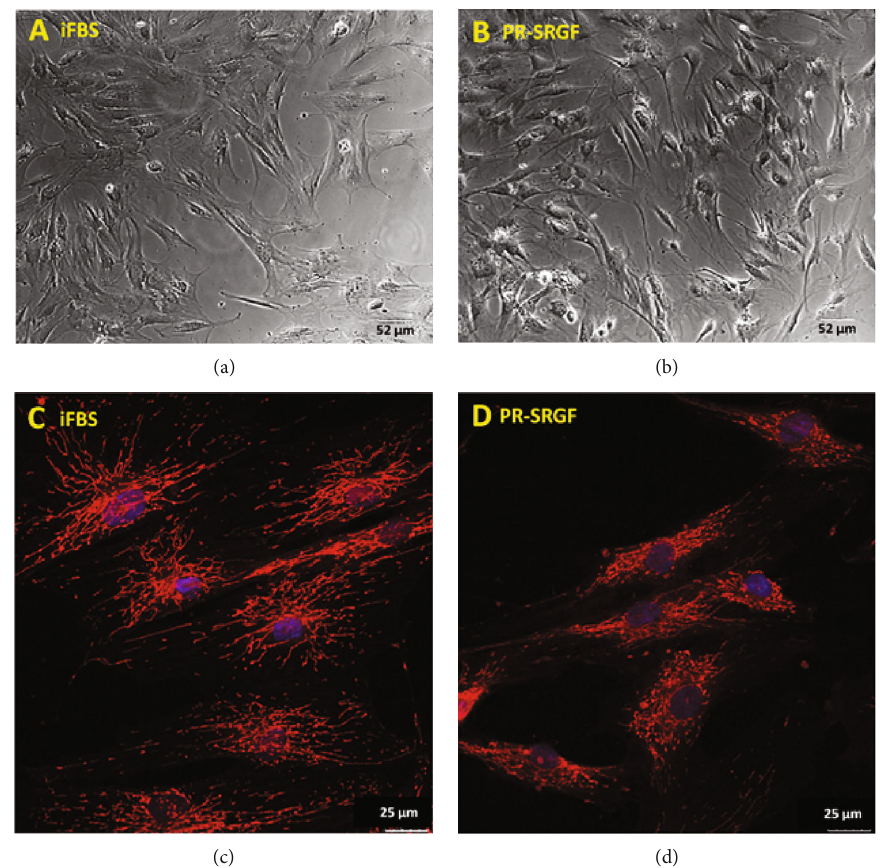
Figure 4: (a, b) Light microscopy of living unstained MSCs (10x lens) cultivated for 48h in medium supplemented with 10% heat inactivated FBS (iFBS) (a) and 7.5% PR-SFGF (b). (c, d) Confocal images of mitochondrial network of fi xed MSC (63x lens) cultivated for 48 h in medium supplemented with 10% heat inactivated FBS (iFBS) (c) and 7.5% PR-SFGF